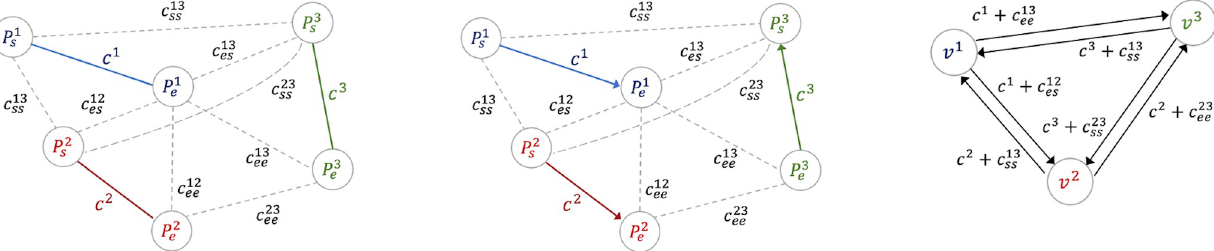
Fig 2. Transformation from RPP to TSP for path merging. (Left) The G The costs of associated to each edge are indicated. The undirected cluster edges ð P i different colors. (Middle) The G merge graph with a random selection of the directions for the undirected cluster edges. (Right) The dual transformed graph G mergeTSP , where the cluster edges ð P i